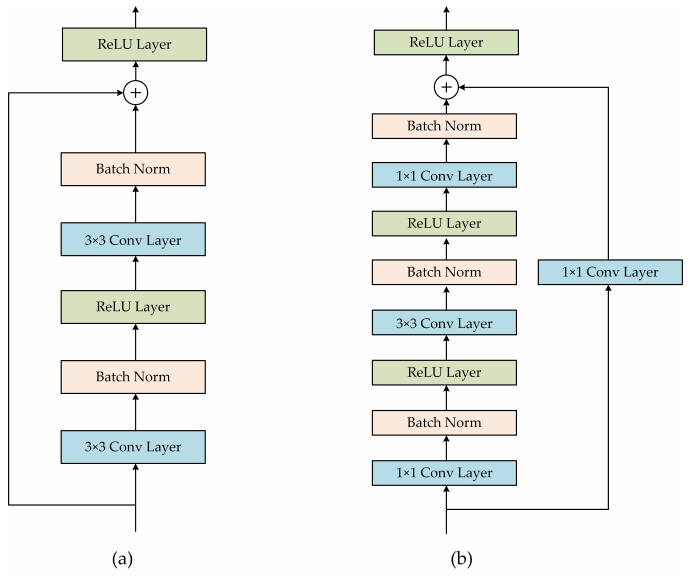
Figure 8. Residual block in ResNet with different number of layers. ( a ) Residual block for ResNet34. ( b ) Residual block for